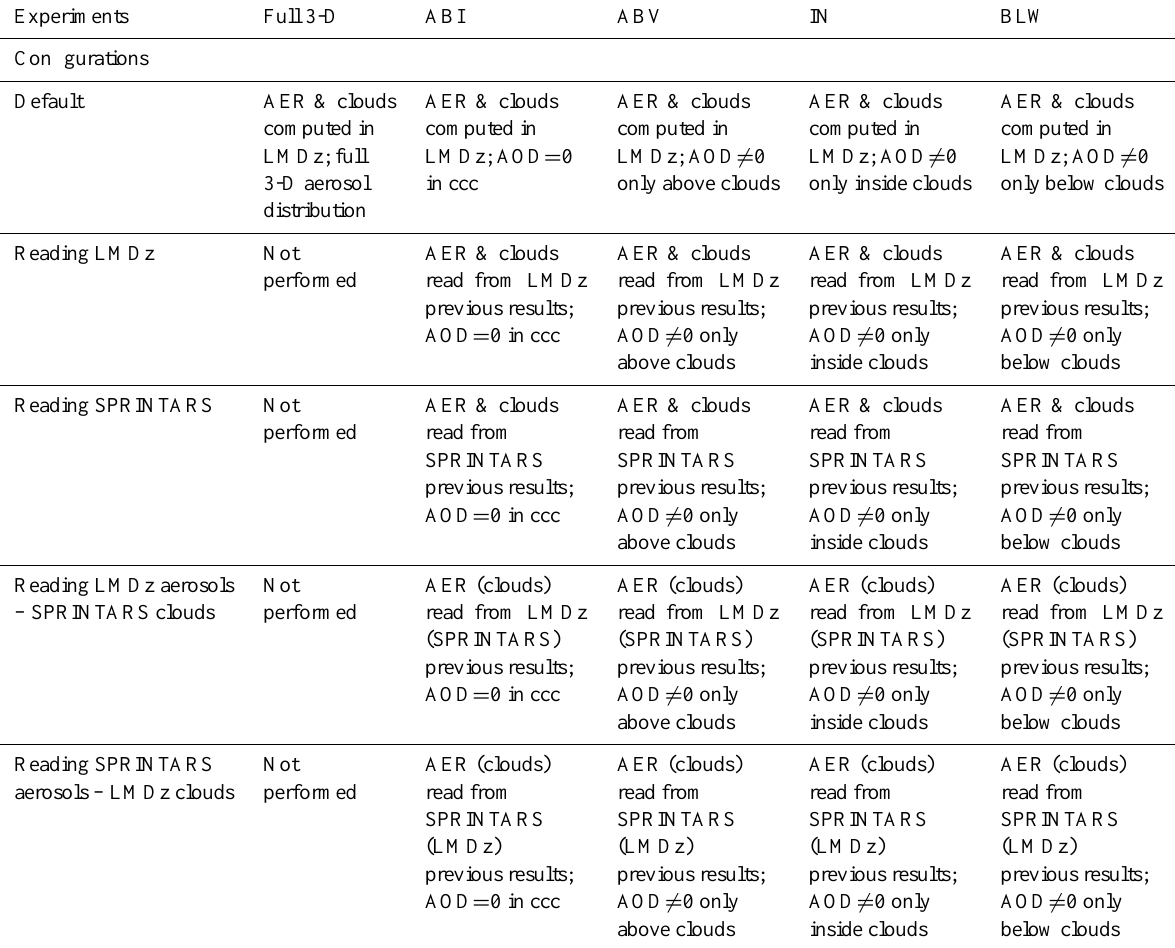
Table 1. Model simulations according to the different origin of aerosols and clouds fields (Configurations) and aerosols vertical distributions relative to clouds (Experiments). “AER” stands for “aerosols” and “ccc” stands for “completely clear